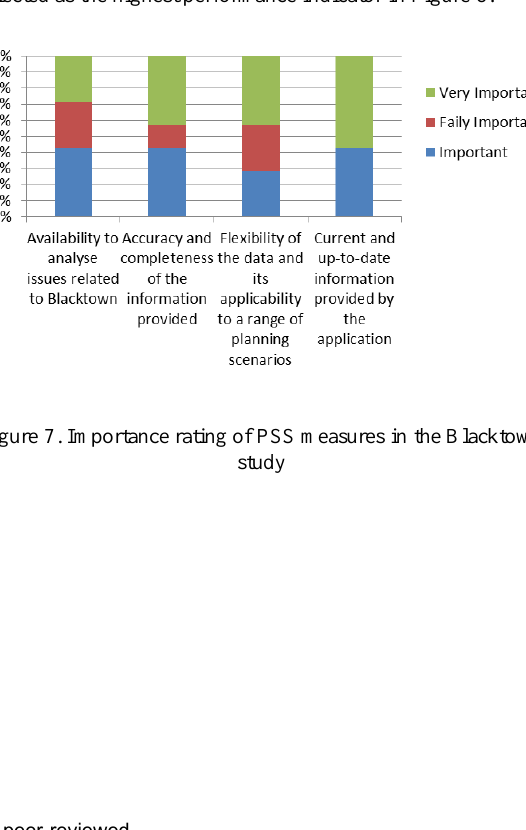
Table 1. An example of dataset items which were included in the PSS